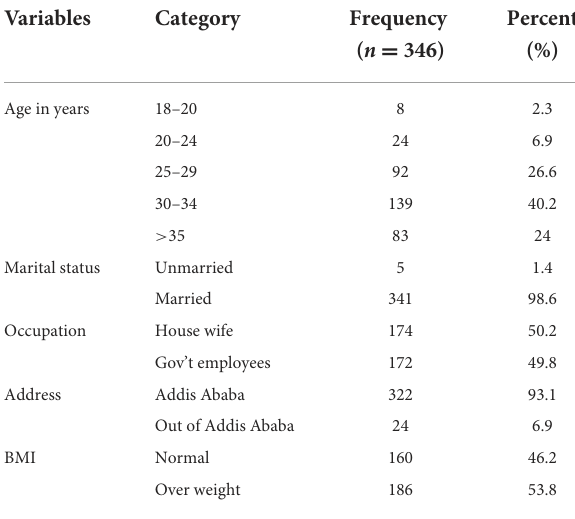
TABLE 1 Socio-demographic characteristics of the diabetic mothers delivered at the Tikur Anbessa Specialized Hospital Addis Ababa, Ethiopia,